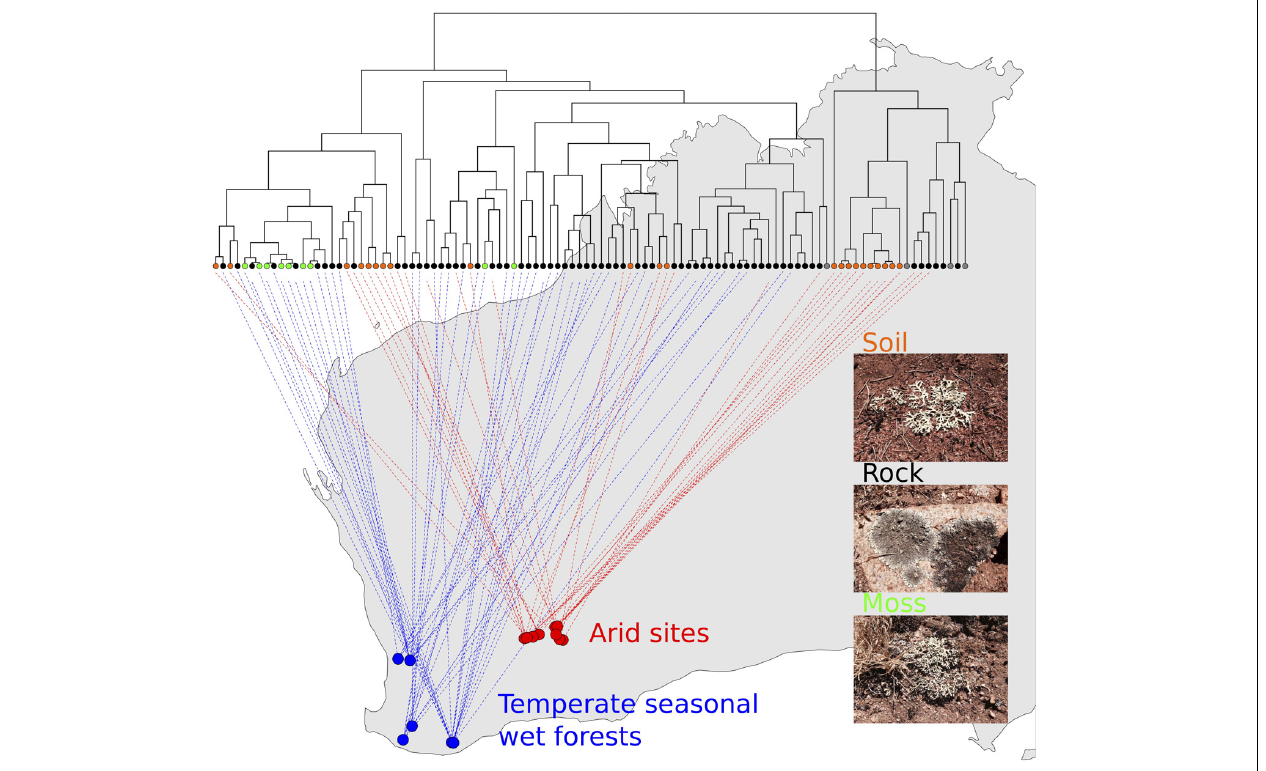
FIGURE 1 | A reconstructed molecular phylogeny of Western Australian species of the lichen-forming fungal genus Xanthoparmelia using a concatenated data set of sequences from ITS, mtSSU, and nuLSU regions and a Bayesian method (BEAST2; see “Materials And Methods” section for details). Dash lines connect samples to their sampling localities. Red color indicates specimens from arid and blue from temperate regions. Color labels of tips of the phylogeny depict the substrate types, where orange represents specimens occurring on soil, black on rocks, and green on mosses. Gray tips are samples from outside of Western Australia (eastern Australia and Africa). Photo images were taken by